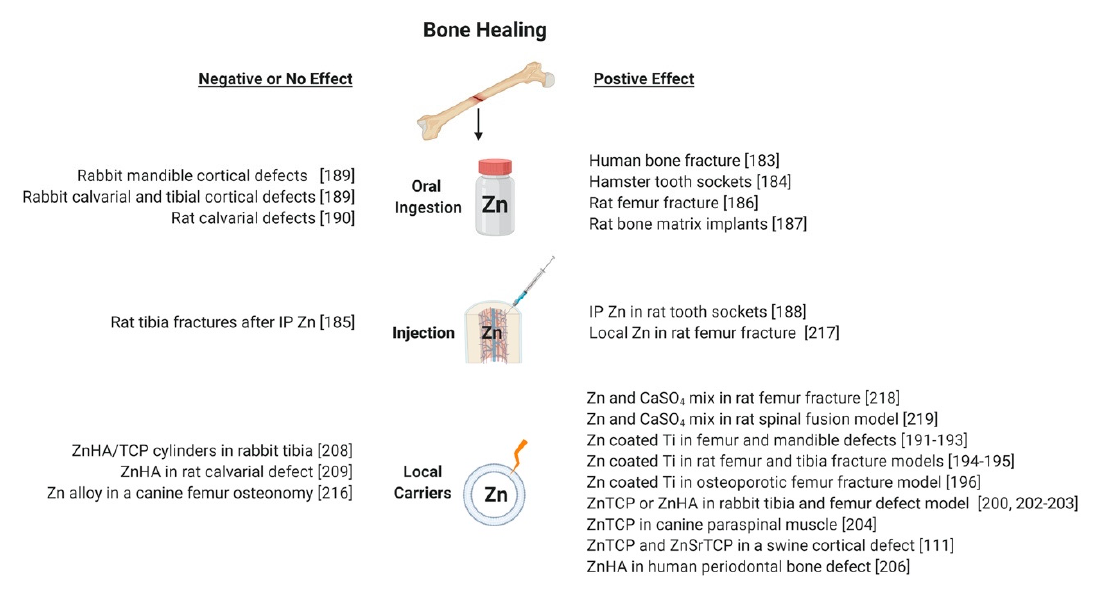
Figure 3. Promoting Bone Regeneration with Zinc.